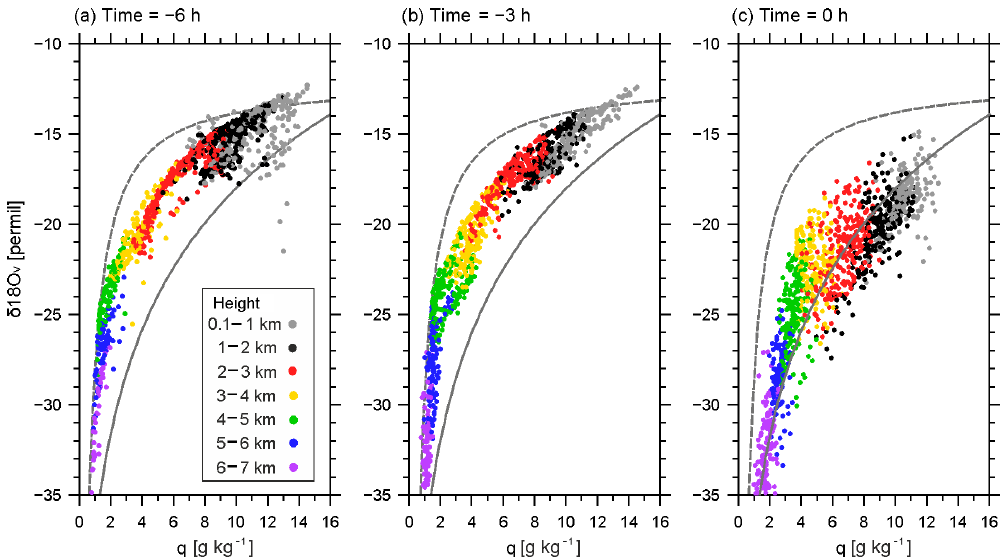
Figure 9. Scatter diagram of q and δ 18 O v along the backward trajectories of Fig. 7 but for all altitudes of 1–2km (black dots), 2–3km (red dots), 3–4km (yellow dots), 4–5km (green dots), 5–6km (blue dots), and 6–7km (purple dots) at (a) − 6h, (b) − 3h, and (c) 0h from 20:00UTC on 15 October 2012. The mixing and Rayleigh lines are indicated in each panel by dashed and solid lines,